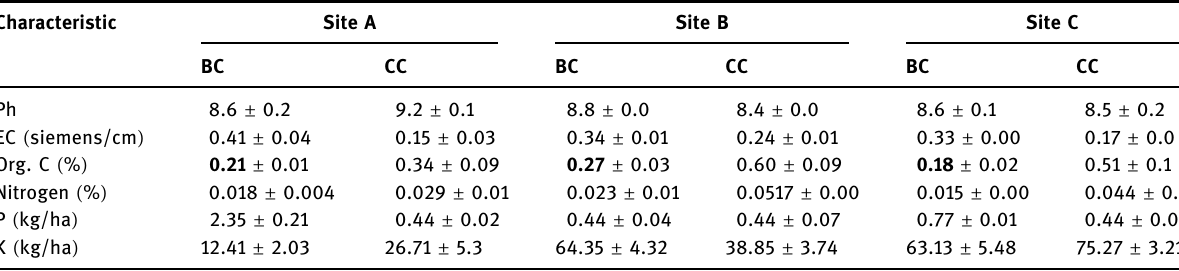
Note: Bold values show low organic carbon and high electrical conductivity values, signi fi cant to soil analysis result, highlighting anamoly in Bt cotton soil